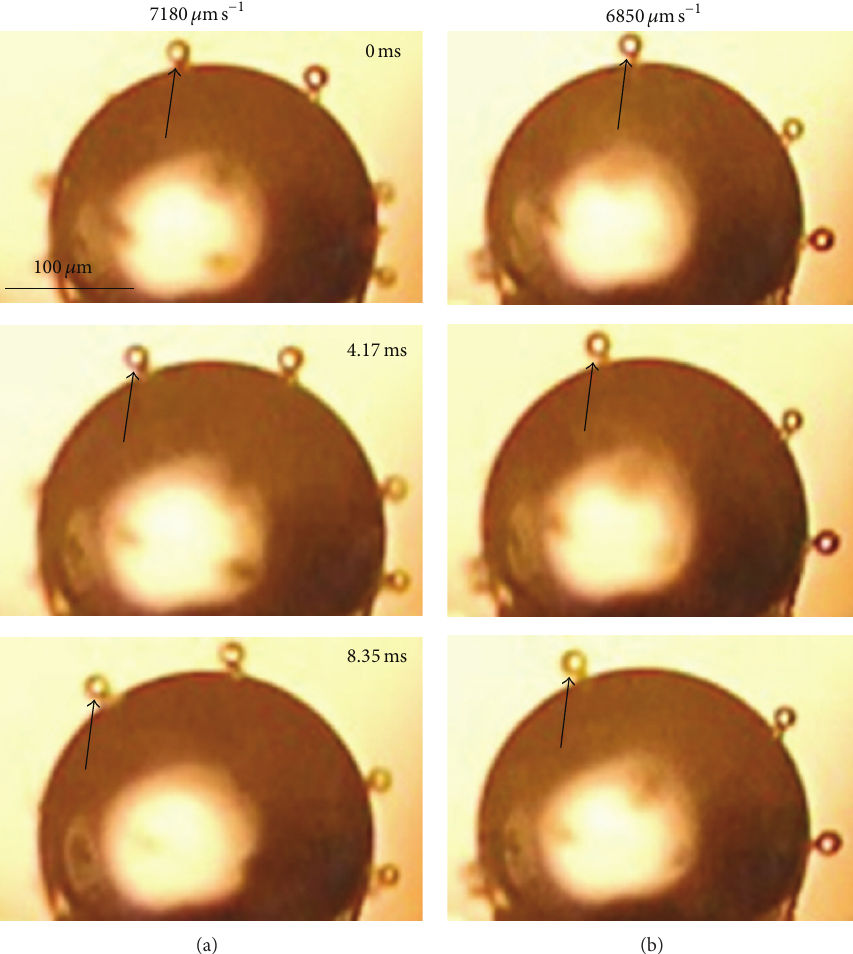
Figure 2: Optical images of time sequences demonstrating mobility of the particle-droplet pairs from an external air current. (a) and (b) show movement over time with particle-droplet pairs travelling at around 7000 𝜇 ms −1 (see also Movies S2, S3, and